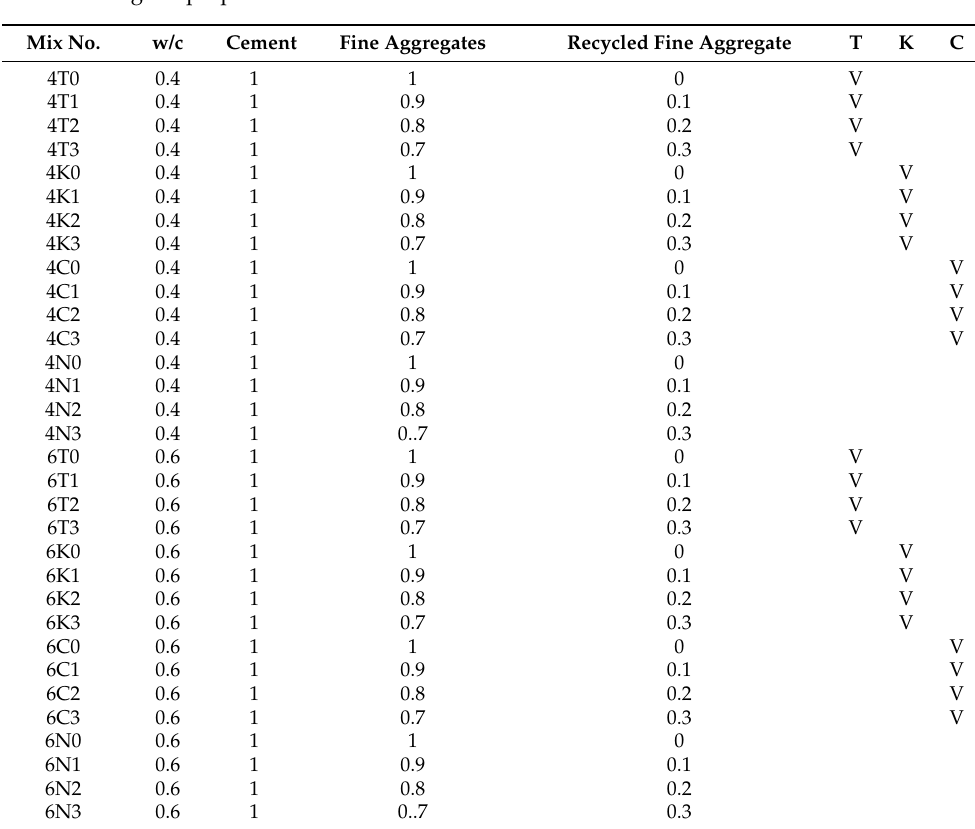
Table 5. Designed proportions in cement